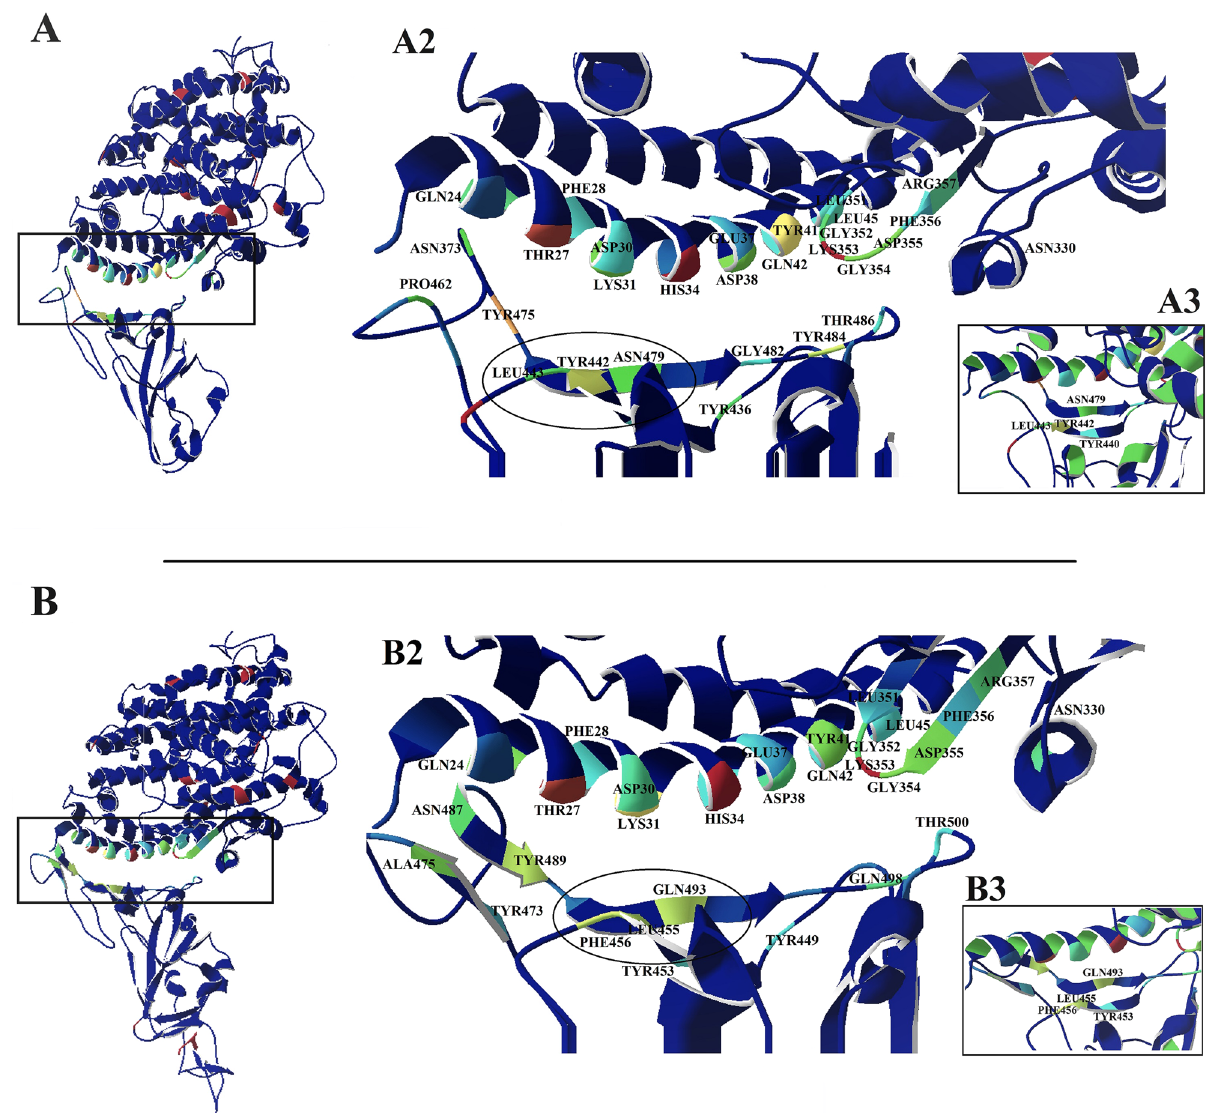
Figure 6. Native contact pattern for the SARS-CoV and SARS-CoV2 in interaction with ACE2: The native contact pattern between the receptor-binding motif of the spike protein and ACE2 in SARS-CoV ( A ) and SARS- CoV-2 ( B ) during the simulation. Residues with high values of the native contact (based on R-factor) involved in the interactions are designated as green, yellow, and red which identified in part A2 and B2. A3 and B3 are the region located in the middle of the receptor-binding motif in SARS-CoV and SARS-CoV-2 respectively that acts as a clamp for the binding of the virus to ACE2. The images have been obtained by Swiss-PDB viewer 4.0.1 46 (https:// spdbv. vital- it. ch/).